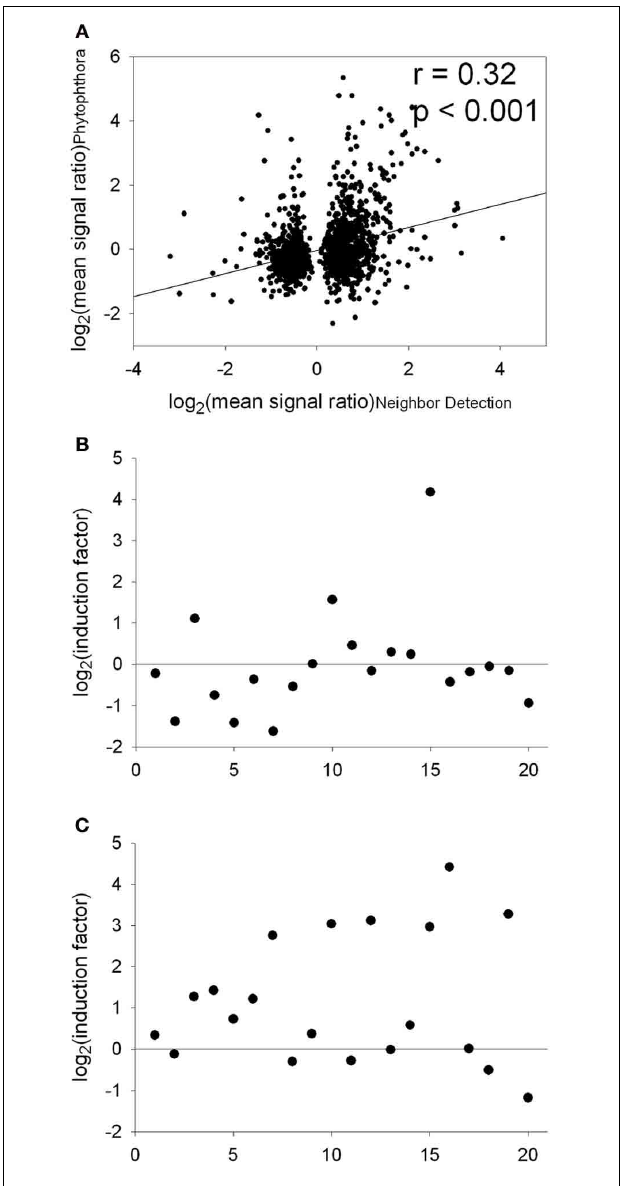
FIGURE 4 | Comparison of transcript abundance in the “neighbor perception experiment” and the “ Phytophthora interaction study” [Attard et al., 2010; data downloaded from the Gene Expression Omnibus epository of the National Center for Biotechnology Information ( http://www . ncbi . nlm . nih . gov/ )]. (A) , Correlation of log 2 (mean signal ratio) comprising all genes significantly regulated in the “neighbor perception experiment.” (B) , Plot of the 20 genes most strongly repressed in the “neighbor perception experiment” vs. the according induction factors from the “ Phytophthora interaction study.” (C) , Plot of the 20 genes most strongly induced in the “neighbor perception experiment” vs. the according induction factors from the “ Phytophthora interaction study.”